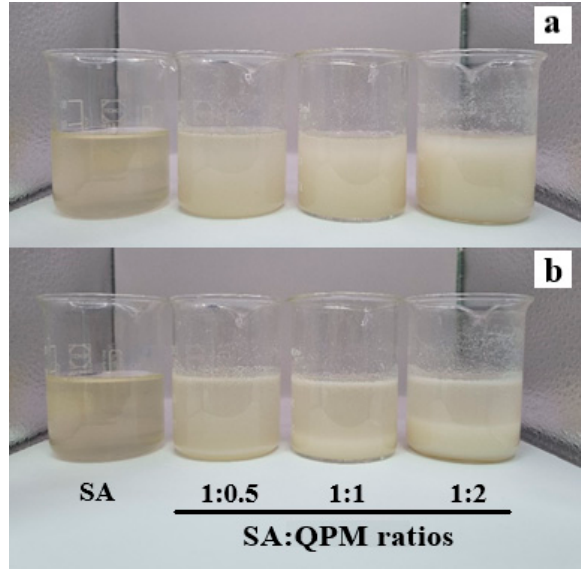
Figure 1. Appearance of SA and SA-QPM dispersions after preparation ( a ) and storing at room temperature for 24 h ( b ).